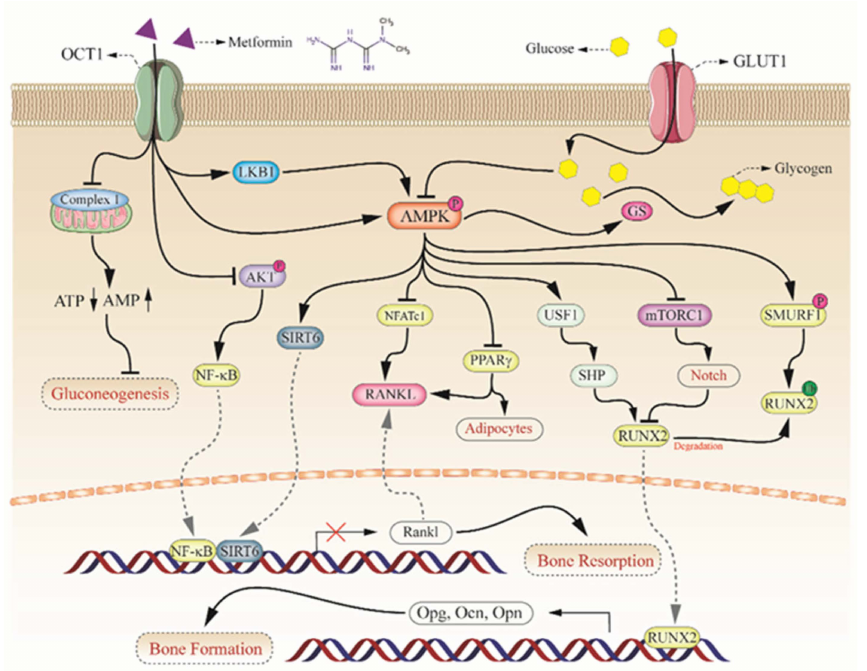
Figure 2. The effect of metformin on bone health. In the osteogenesis, metformin was pumped into osteogenic cells by OCT1, and inhibited gluconeogenesis through the inhibition of mitochondrial respiratory chain complex 1. Metformin inhibited the activation of AKT to reduce the production of cytoplasmic NF-kB, however, metformin activated AMPKa to enhance the expression of sirt6. In the nucleus, the binding of SIRT6 and NF-kB reduced the expression of RANKL which is a key ligand inducing the differentiation of osteoclast in bone remodeling. In addition, the activated AMPKa inhibits factors of NFATc1 and PPARg to repress the expression of RANKL respectively. However, it seems contradictory to the factor of RUNX2 in bone formation. Canonical AMPKa